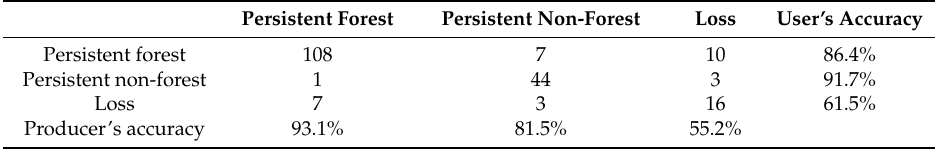
Table 3. Forest change validation; 2000–2007. Validation was done using annual NDVI forest change dataset derived from points visually interpreted using Landsat and high-resolution imagery. If areas classified as forest in 2000 showed decreases in NDVI values during adjacent year periods afterwards (e.g., between 2001 and 2002, 2003 and 2004, and so on through 2007), then the change areas were classed as forest loss. Areas that did not show changes in the forested or non-forested areas were classed as persistent forest or persistent non-forest. Overall accuracy using this approach was